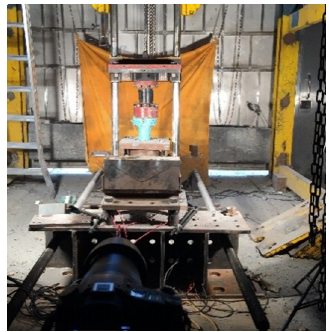
Figure 4. Drop-weight test setup. Table 2. Summary of specimens for the drop-weight impact test.